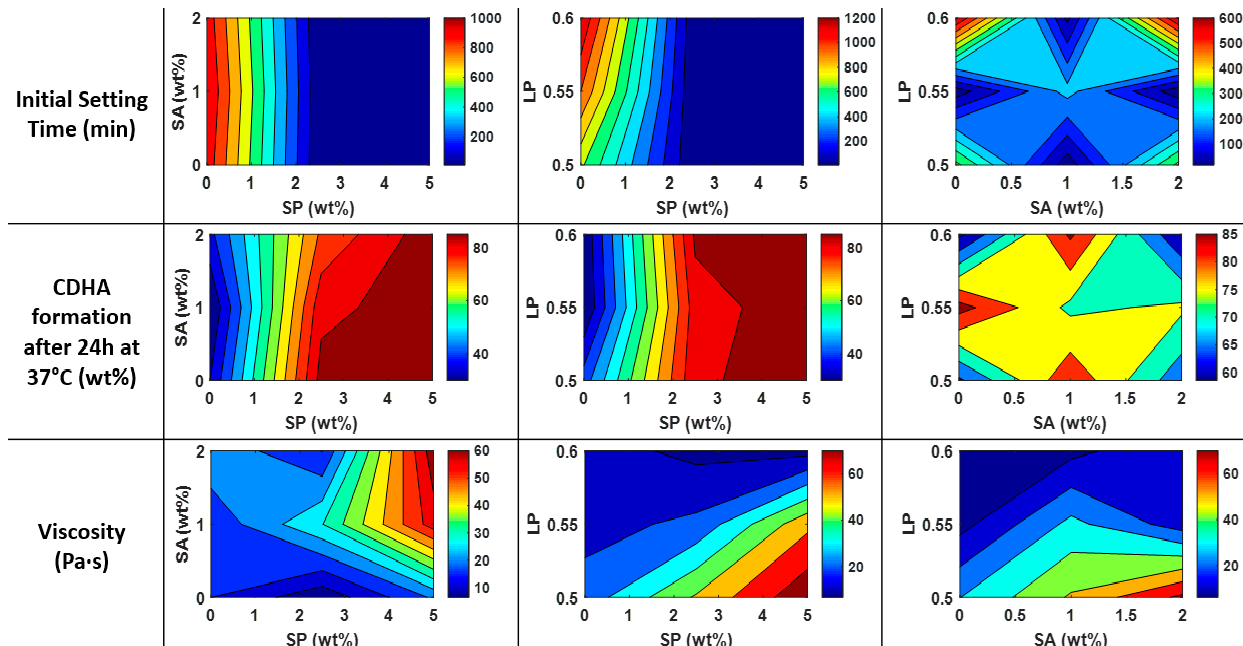
Figure 8. Contour plots related to the Setting Solution and Mixing scheme: The effects of sodium phosphate (SP), sodium alginate (SA), and liquid-to-powder ratio (LP) on the initial setting time (first row), powder hydraulic reactivity (second row), and viscosity (third row). The output variables are represented, as reported in the colored scale bars, from blue (lower values) to red (higher values).